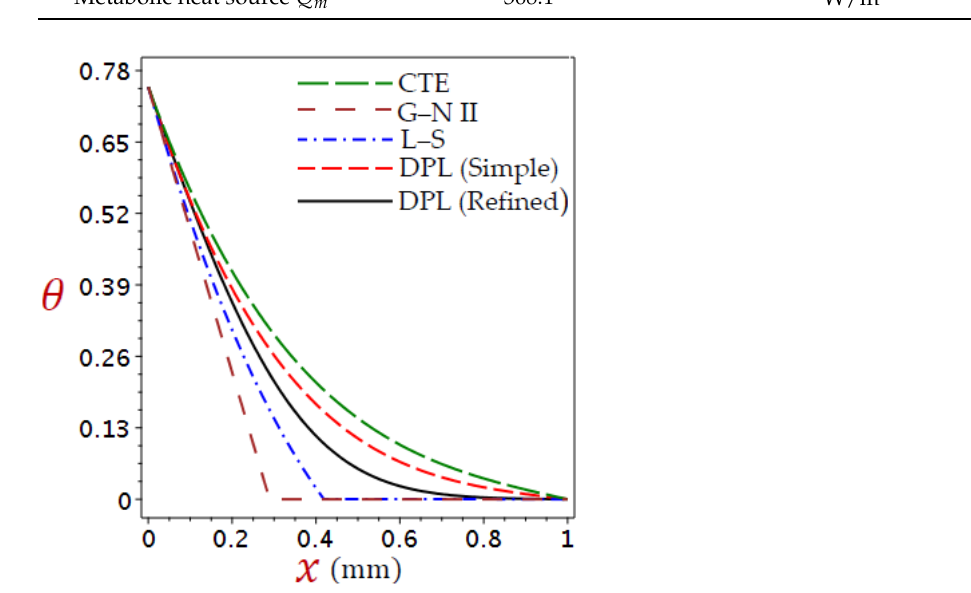
Figure 2. Comparison of variation of temperature (𝜃) across the skin tissue utilizing numerous theories.